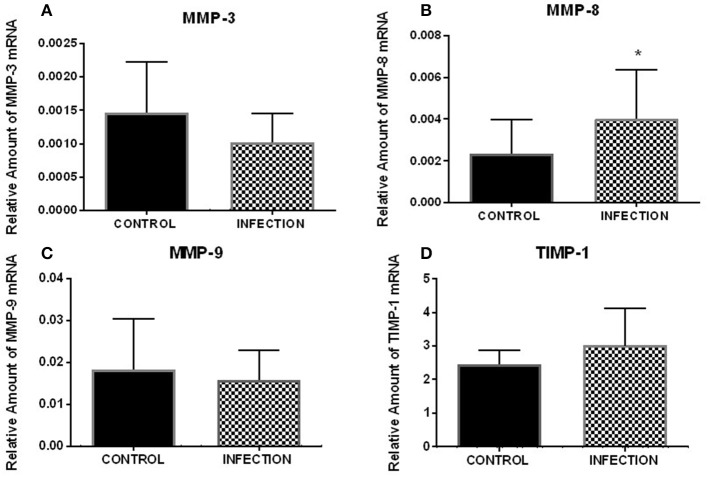
Relative expression of analyzed genes after FT explant infection with Ngo. Relative expression of MMP-3 (A), MMP-8 (B), MMP-9 (C), and TIMP-1 (D) after 12 h of infection (n = 8). The results show a significant variation in MMP-8 (p < 0.05). Each bar represents the mean ± SEM. *Indicates a significant change.